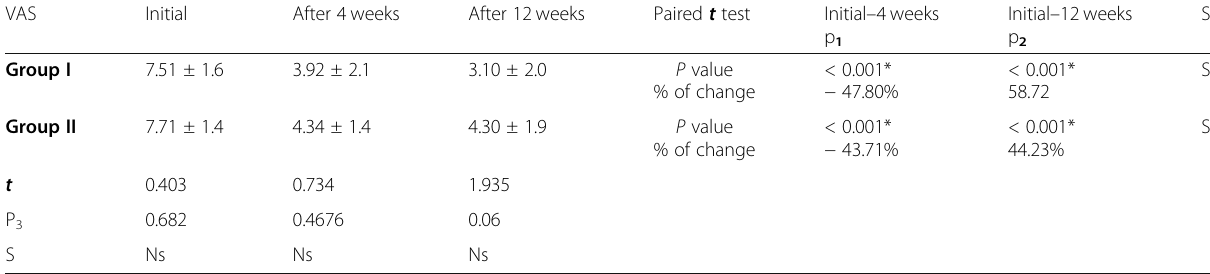
Table 2 Comparison between the two groups as regards VAS score initially, at 4 weeks and after 12 weeks VAS Initial After 4 weeks After 12